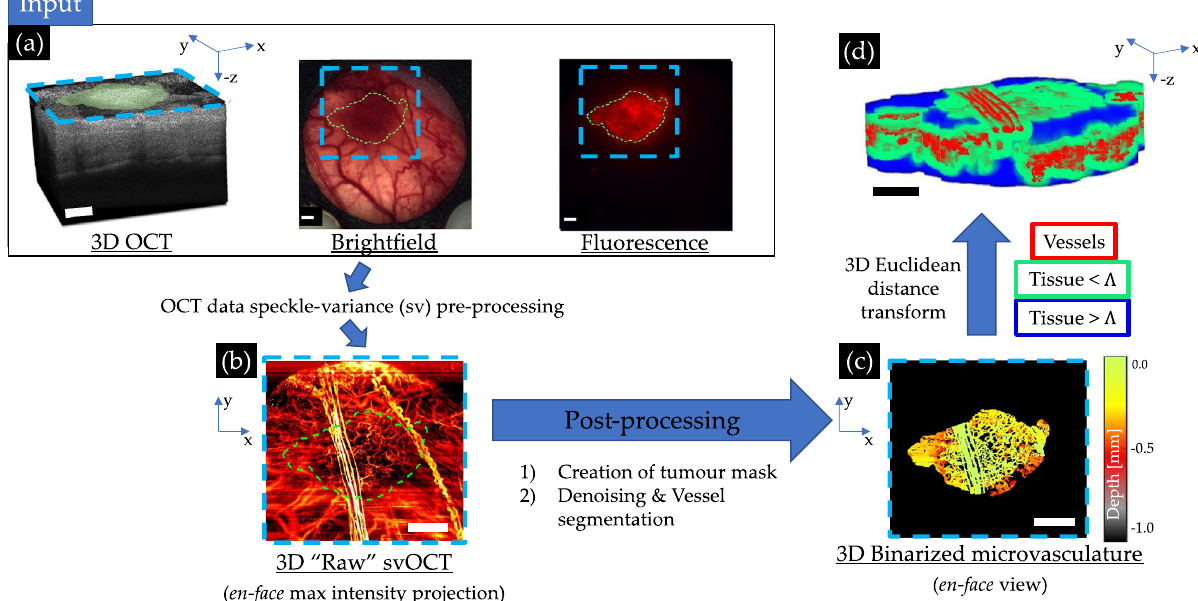
Figure 1. svOCT microvascular segmentation pipeline to enable extraction of diffusion limited fraction DLF (cid:31) and the vascular convexity index (cid:31) : ( a ) 3D structural OCT image along with corresponding brightfield and DsRed fluorescence micrographs; blue contours indicate the FOV of the corresponding OCT scan, green contours the tumour in the lateral plane; ( b ) en-face 2D maximum intensity projection of the resultant microvasculature obtained via svOCT processing using Eq. (1); ( c ) depth-encoded en-face projection of the binarized microvasculature in the segmented tumour VOI; ( d ) Colour-coded 3D representation of distance transformed binarized svOCT volume delineating vessels (red), as well as both proximal ( (cid:31) 150 μm, green) and distant ( (cid:31) 150 μm, blue) tissue voxels from the nearest vessel. This final image enables all computations pertaining to the distance to nearest vessel (DNV) histograms (for details, see text, Sect. Tissue microvasculature heterogeneity quantification). Scale bars are 1 mm, 3D volumes are 6 6 1 mm 3 ( lateral 2 depth ). All images above are derived from the same mouse-timepoint data × × × acquisition. Green lateral tumour contours were generated based on the raw brightfield and fluorescence images (shown above) using MATLAB R2021a software. OCT-derived images were generated by processing the same raw OCT acquisition using custom scripts in MATLAB R2021a software (https:// github. com/ nalla m1/ Batch- proce ssing- multi modal ity- tumour- imagi ng). Organization of the images for display was completed in Microsoft